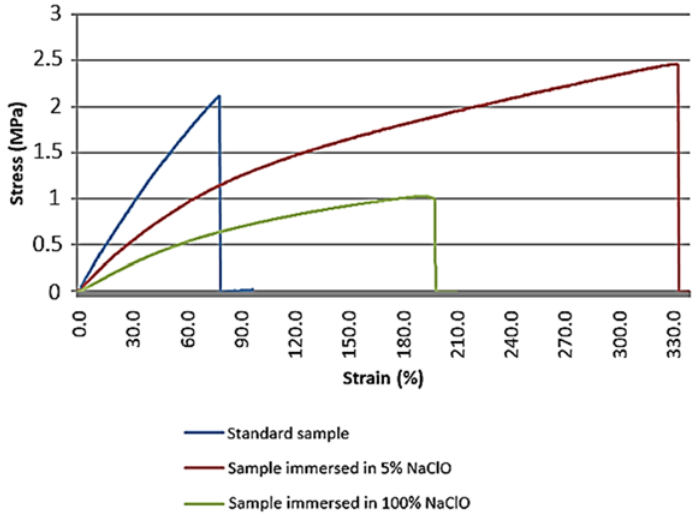
Figure 18. Stress-strain graph of the oak tensile test for the standard sample and samples immersed for three months in 5% and 100% NaClO. Table 8. Values achieved by oak at maximum force during tensile testing of the standard sample and samples immersed for three weeks in 5% and 100% NaClO.